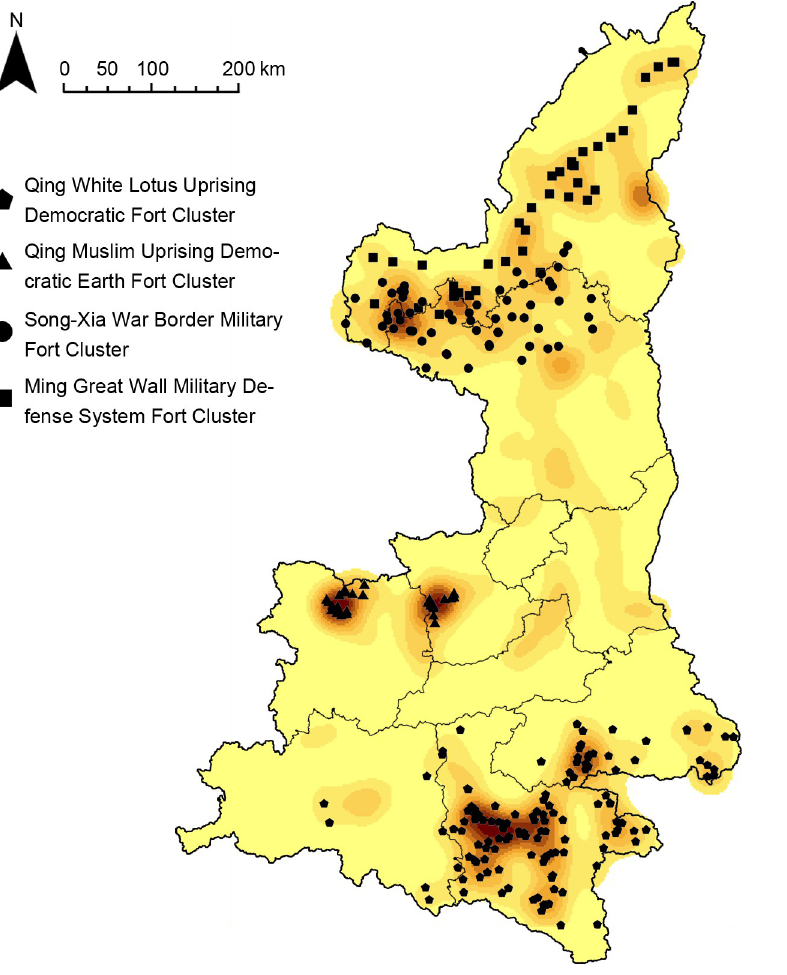
Fig 8. Group system distribution